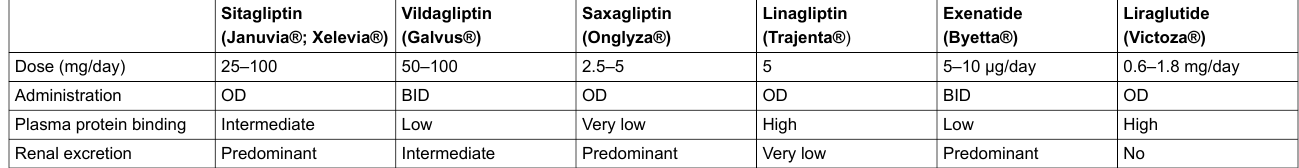
Table 2: Pharmacokinetic properties of